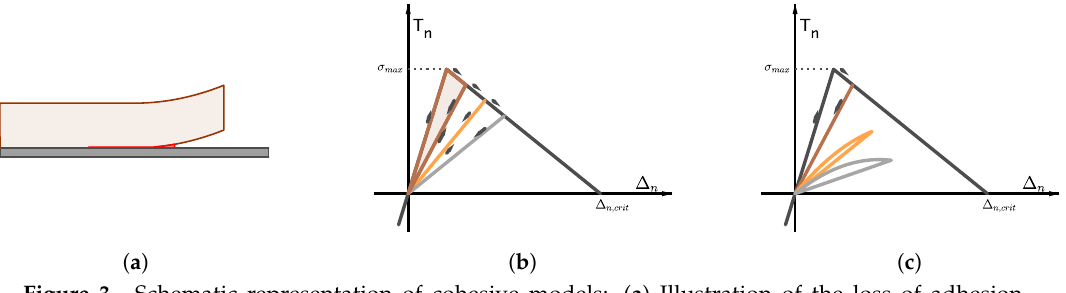
Figure 3. Schematic representation of cohesive models: ( a ) Illustration of the loss of adhesion at the coating-substrate interface; ( b ) Bi-linear traction-separation law. The arrows indicate the loading and unloading paths; and ( c ) Traction-separation law when the cohesive stiffness is degraded during